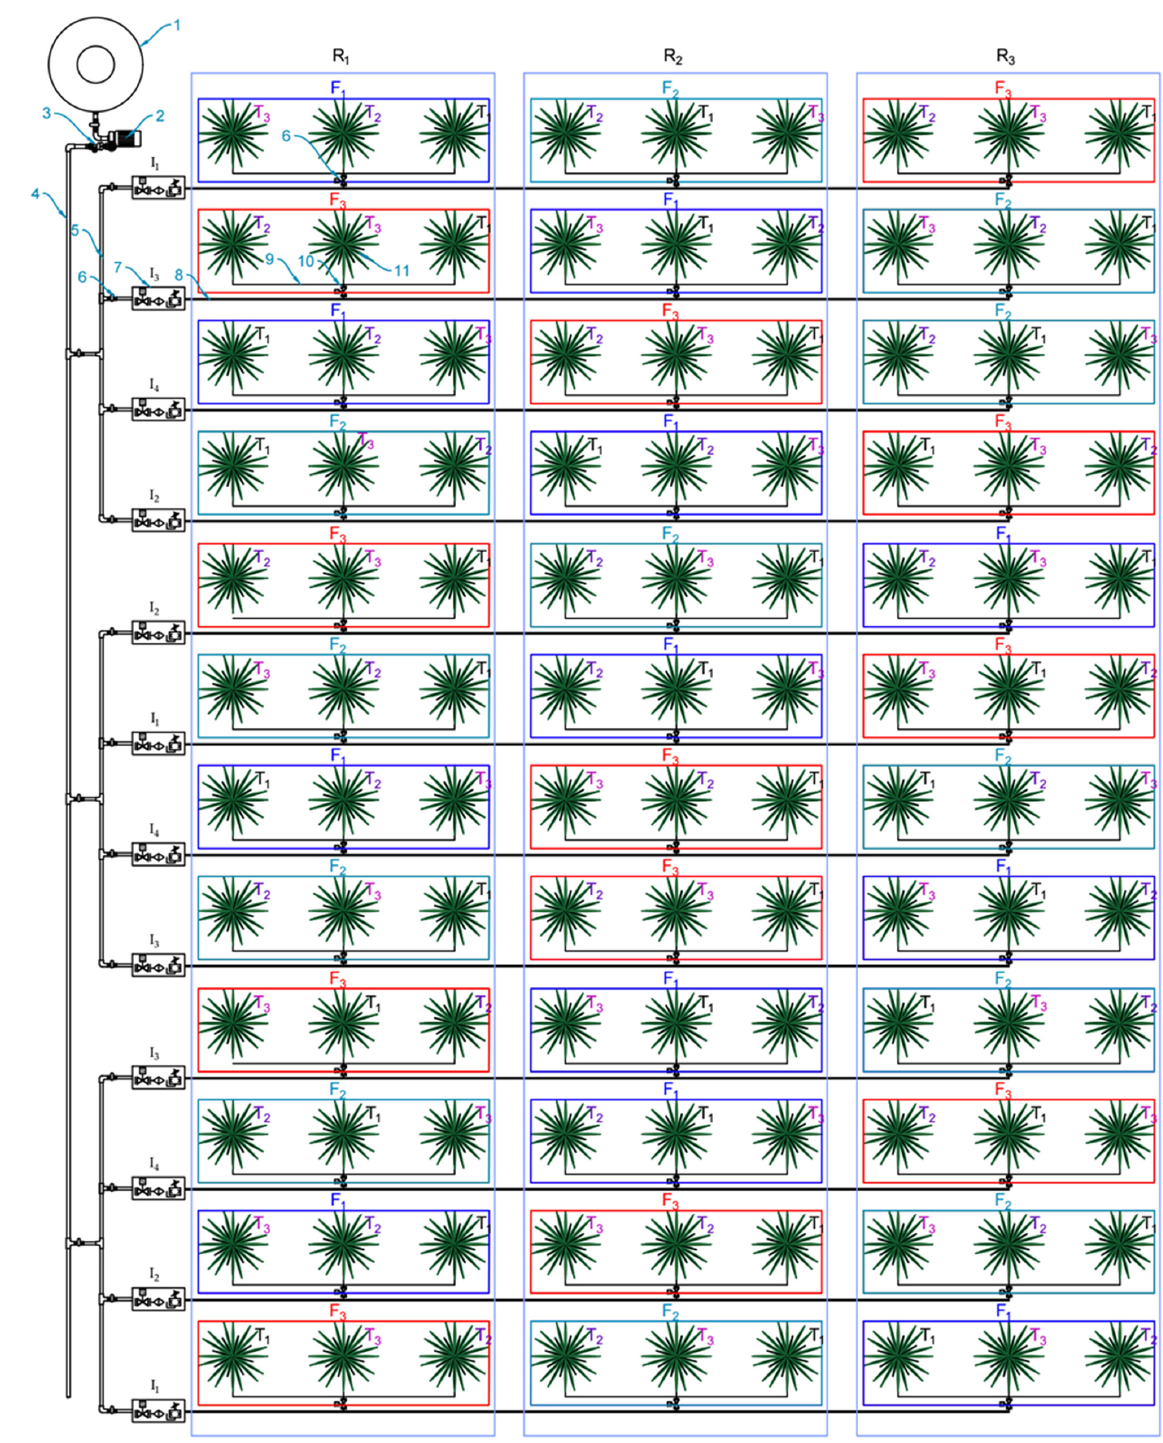
Figure 5. The layout of the experiment. (1) Water tank, (2) irrigation water pump, (3) pressure regulator, (4) main line, (5) sub main line, (6) manual valve, (7) control zone kit, (8) lateral line, (9) distribution line, (10) flow meter, and (11) date palm tree. The layout of the experiment was a three factorial completely randomized block design, i.e., four irrigation levels (I 1 , I 2 , I 3 , and I 4 ), three SOP fertilizer doses (F 1 , F 2 , and F 3 ), and three bunch thinning levels (T 1 , T 2 , and T 3 ), each treatments combination having three replications (R 1 , R 2 , and R 3 ).